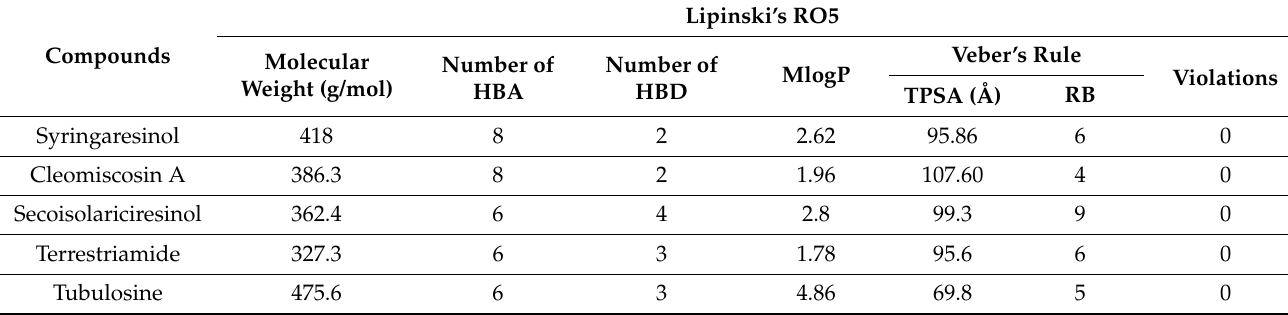
Table 2. Results of compounds examined for Lipinski’s rule.